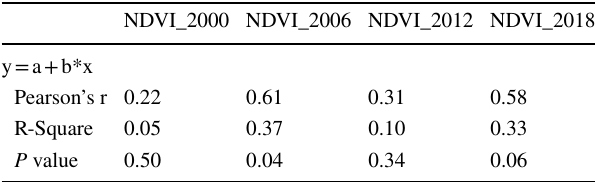
Table 2 Difference between Pearson coefficient and